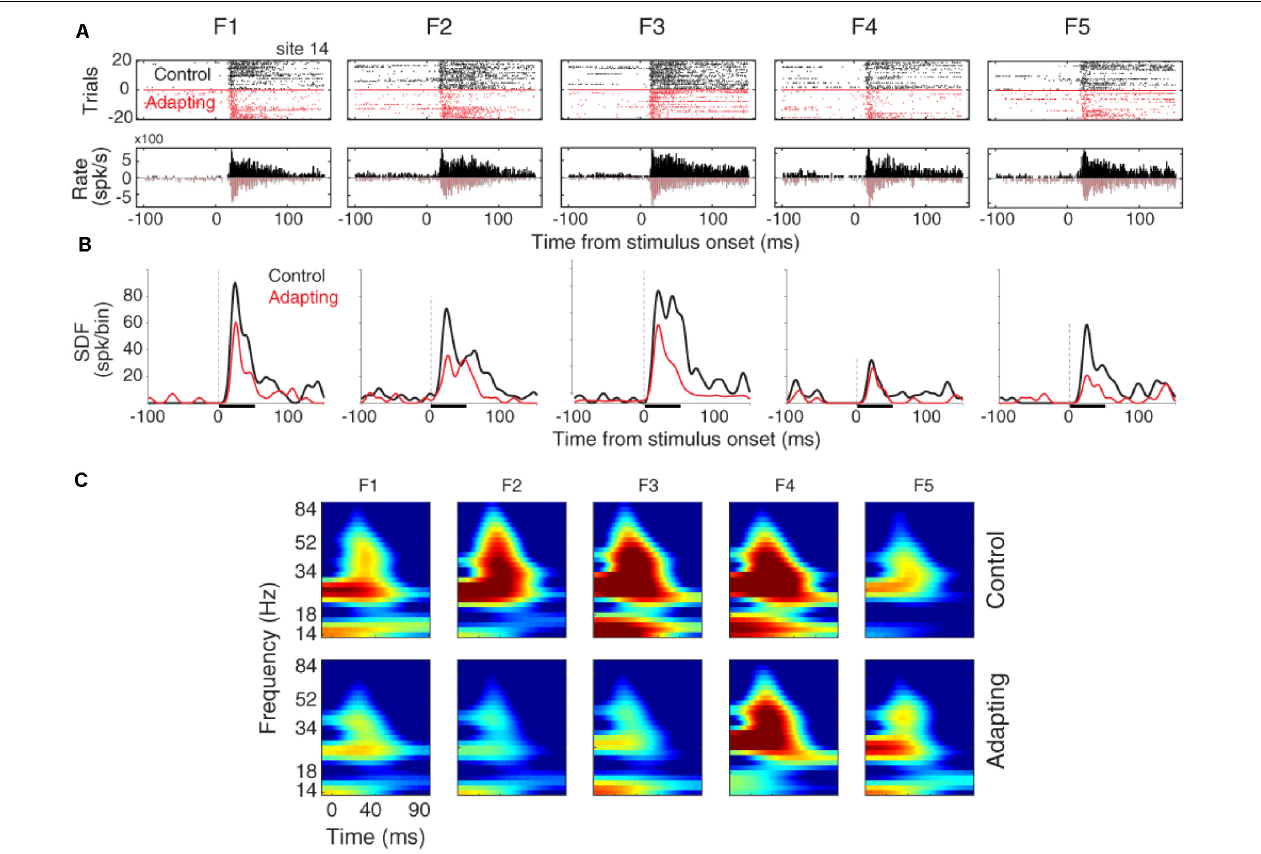
FIGURE 2 | Adaptation impacts on the neuronal spiking activity and LFP responses. (A) Raster plot and peristimulus time histogram (PSTH) of the adapter (tone frequency f3) and its neighboring frequencies at 60 dB SPL intensity for a sample recording site (site 14) in control (black) and adapting (red) sequences. (B) Comparison of spike density function (SDF) between control (black) and adapting (red) sequences for the five respective frequencies of pure tones at 60 dB SPL intensity. (C) Time-frequency representation of the LFP power for different stimuli in a sample recording site (site 14). Color bars show the mean normalized LFP power, as a function of time ( x -axis) and LFP frequency ( y -axis) in the control (top panels) and adaptation (bottom panels)